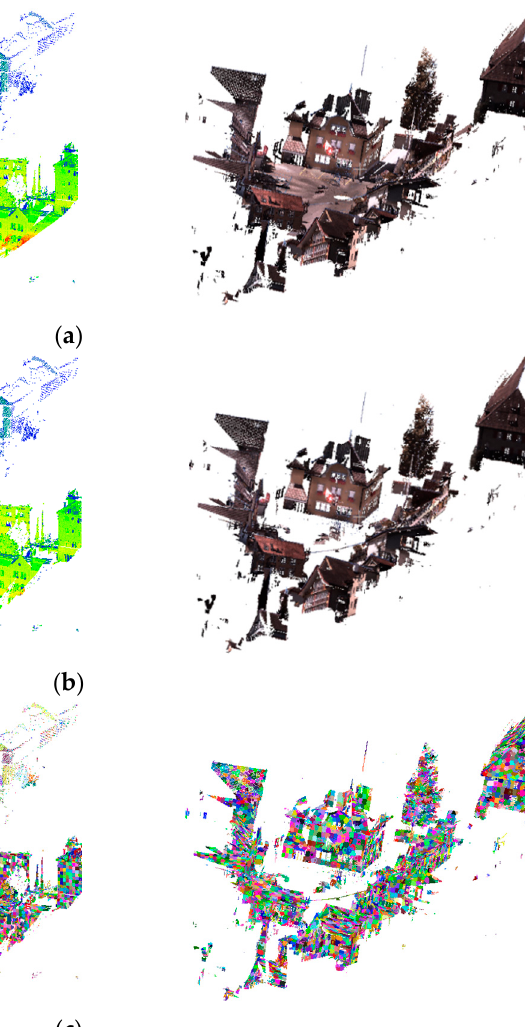
Figure 2. Super-points generated from own ( left ) and benchmark ( right ) datasets. ( a ) Raw data, ( b ) raw data without ground, ( c ) super-points results generated by our method.